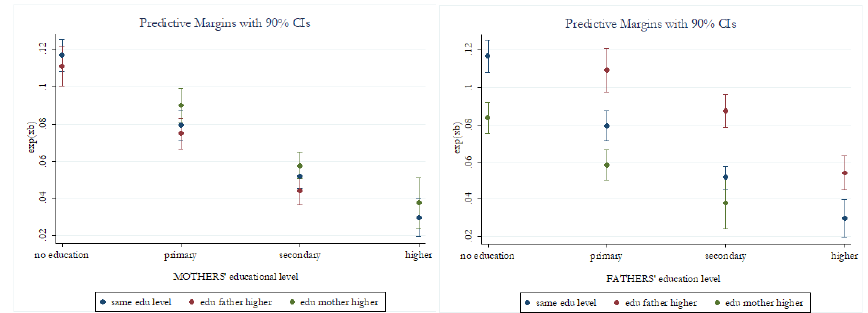
Figure 4 – Average marginal effects of partner’s educational level for mothers (left side) and fathers (right side) on under-five mortality (90% confidence